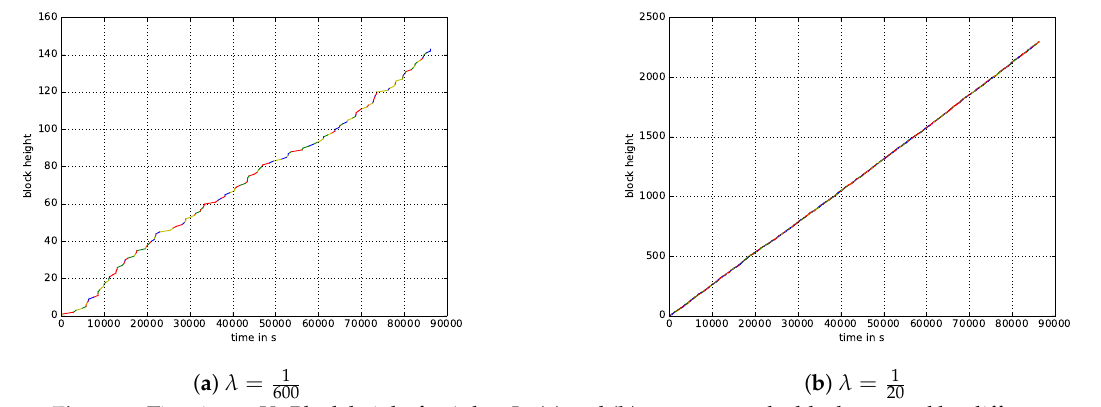
Figure 3. Time in sec Vs Block height for 1 day. In ( a ) and ( b ) you can see the blocks created by different miners in different